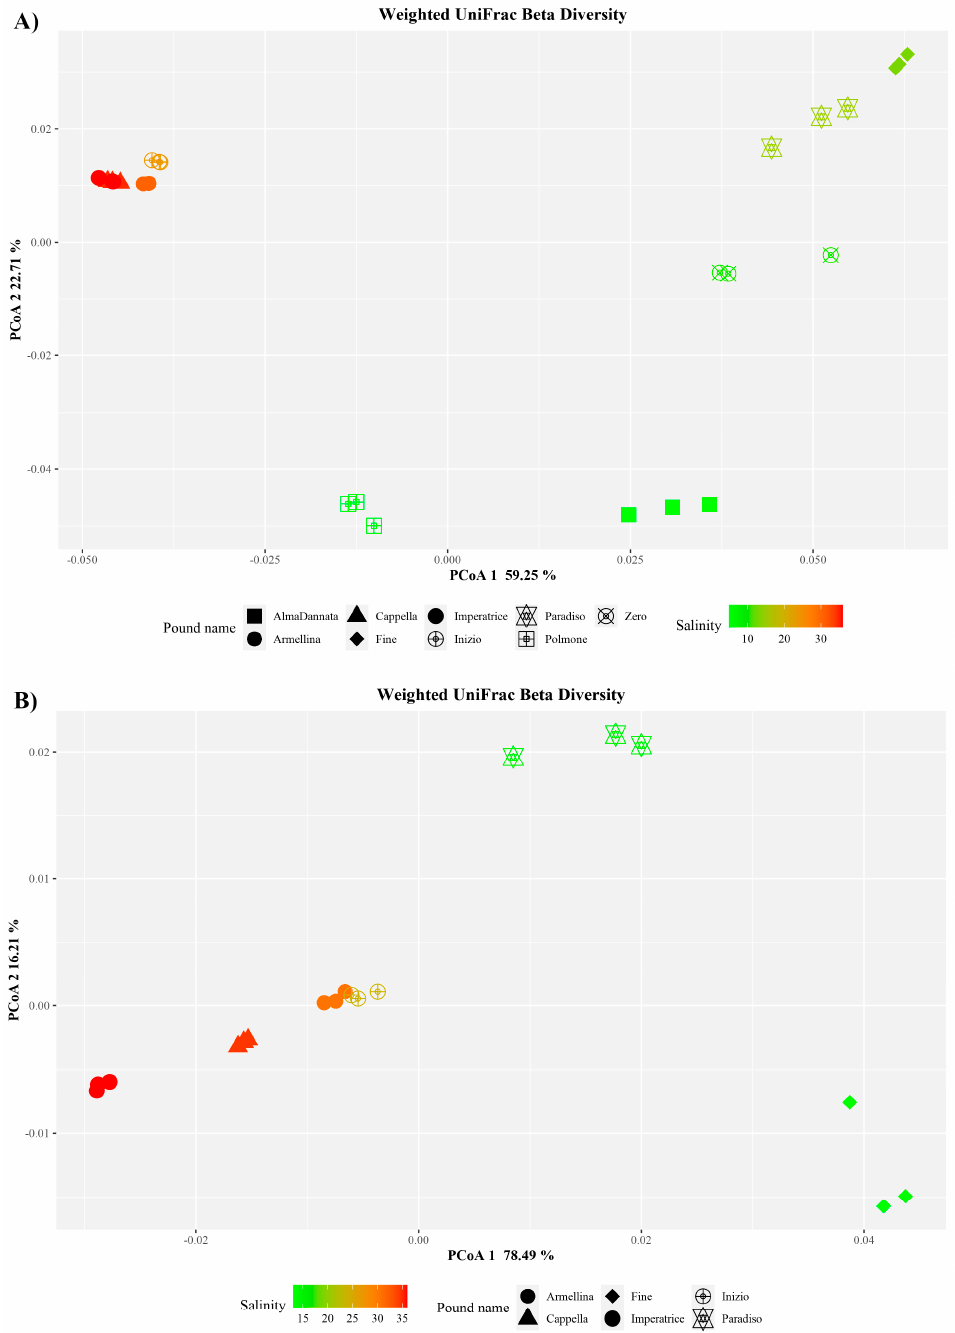
Figure 3. PCoA (Principal Coordinates Analysis) representations of weighted UniFrac analysis. ( A ) Bacteria ; ( B ) Archaea . Salinity is reported as salt percentage (w/v).